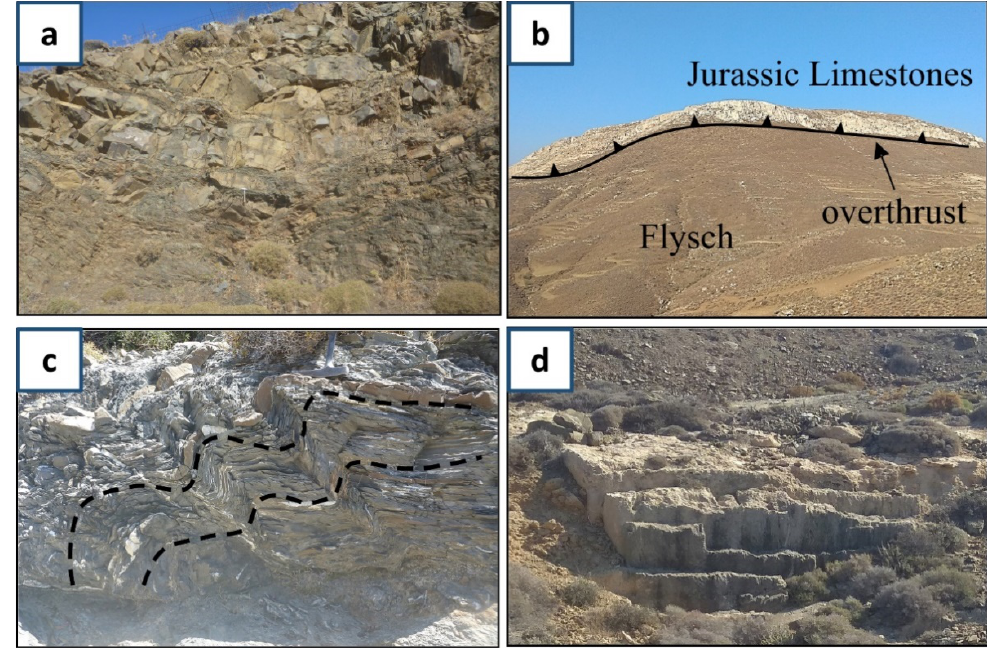
Figure 6. Representative photographs during our field work: ( a ) Sandstone and mudstone interca- lations; ( b ) of the Jurassic limestones over thrusting Eocene flysch; ( c ) characteristics of dynamic deformation through the presence of folded sandstones; ( d ) Calcarenite quarry.